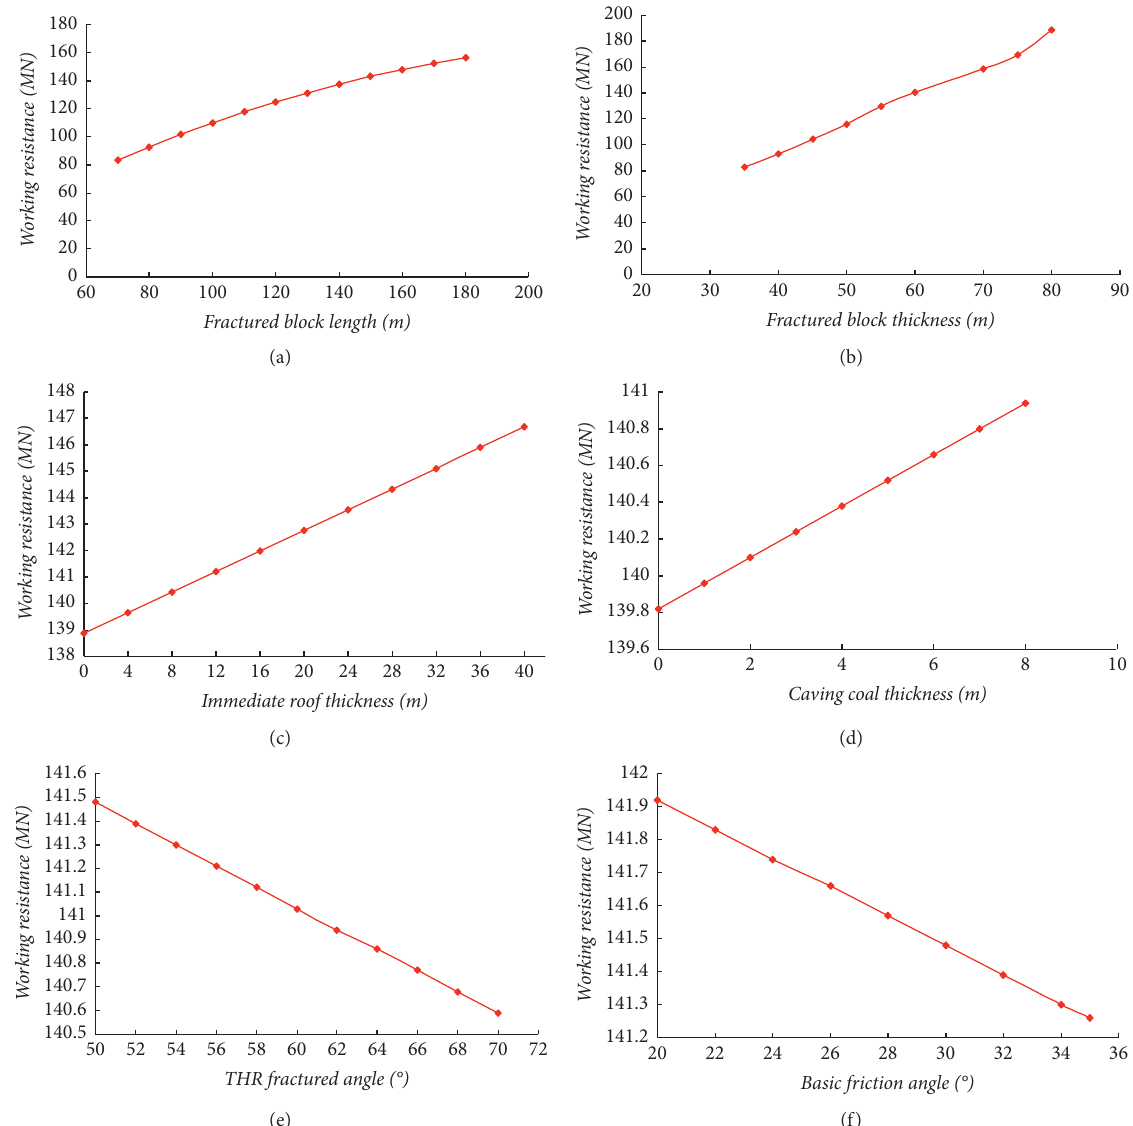
Figure 7: Sensitivity analysis of working resistance during the first